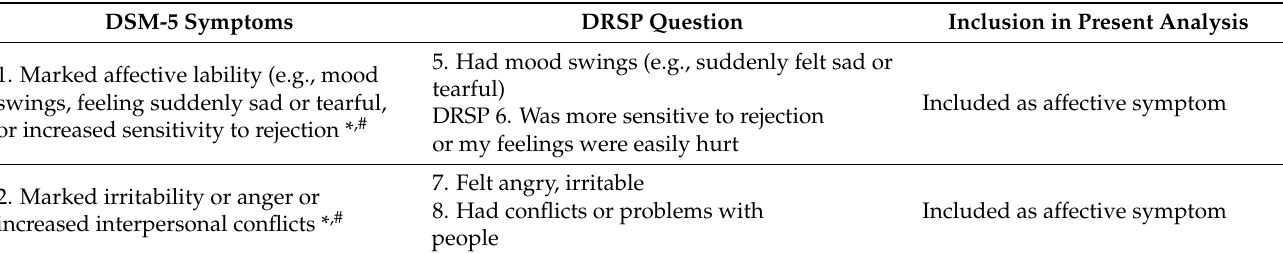
Table A1. Domain type and symptoms of PMDD as specified in